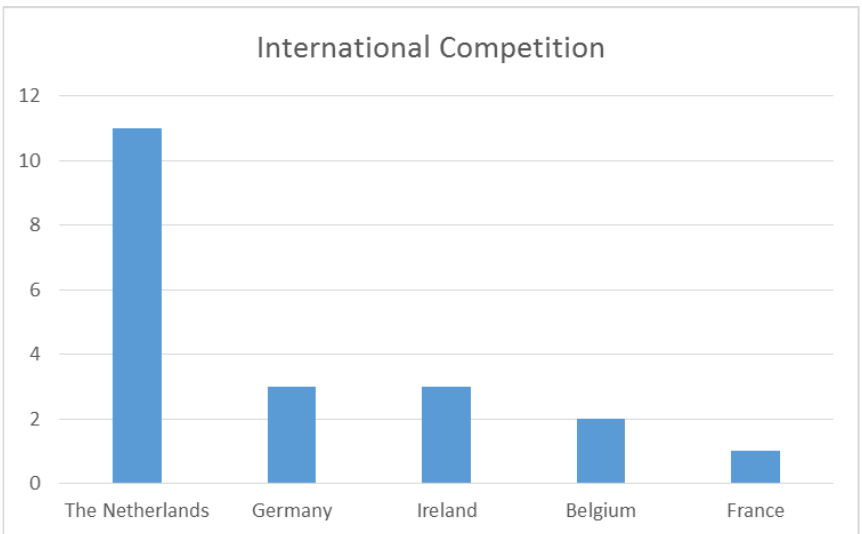
Fig. 5. International competition according to different